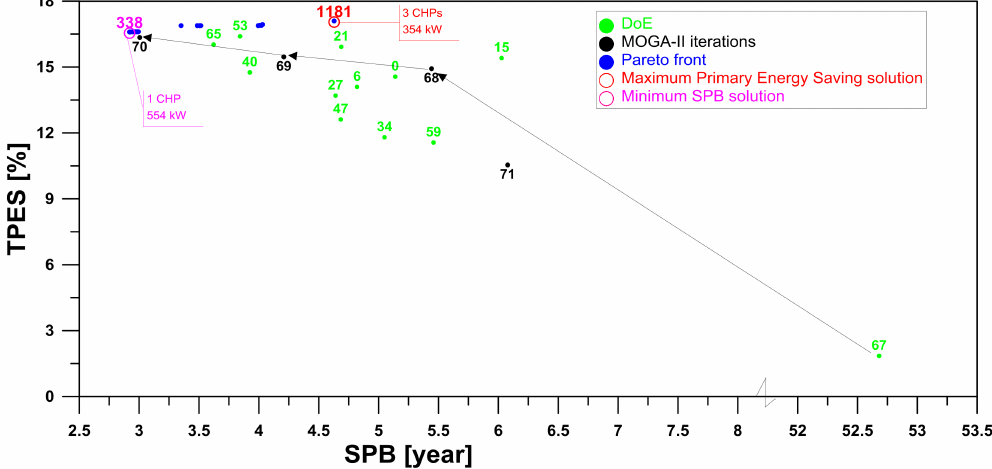
Figure 7. MOGA II’s fast convergence toward Pareto dominant solutions.